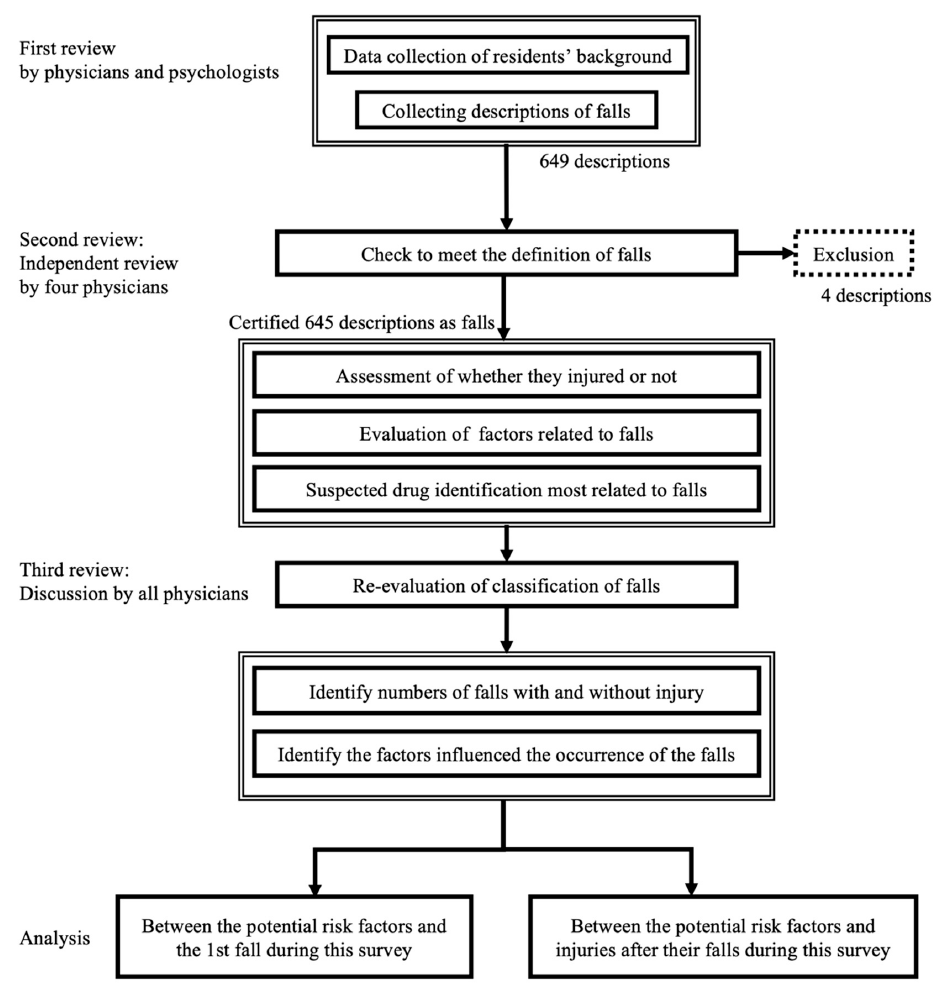
Figure 1. Outline of review